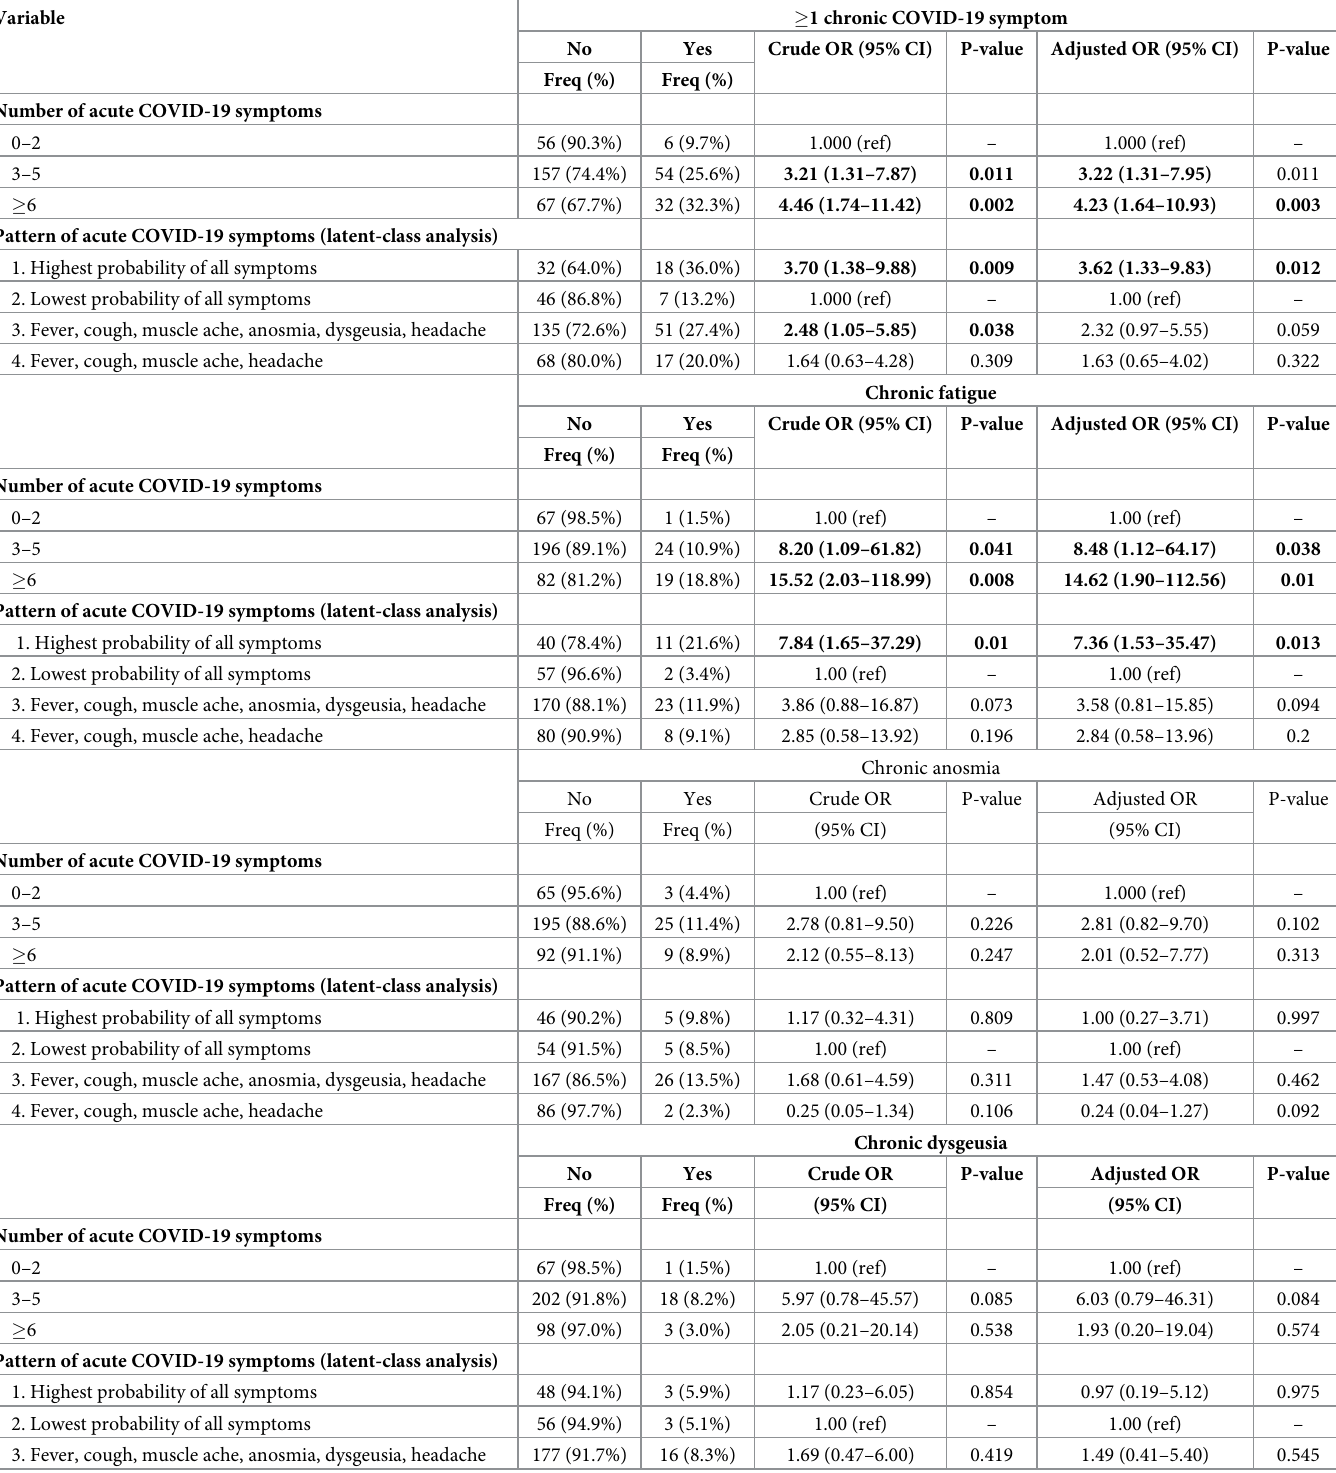
Table 4. Associations of the number and pattern (latent-class analysis) of acute COVID-19 symptoms with any chronic COVID-19 symptom, particularly chronic fatigue, anosmia and dysgeusia.